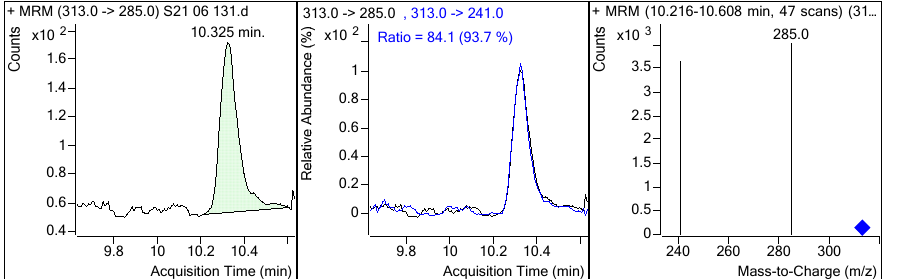
Figure 5. LC-MS/MS selected ion monitoring (SRM) chromatogram of the contaminated liver sam- Figure 5. LC‑MS/MS selected ion monitoring (SRM) chromatogram of the contaminated liver sam‑ ples containing 0.12 µg/kg AFB1. ples containing 0.12 µ g/kg